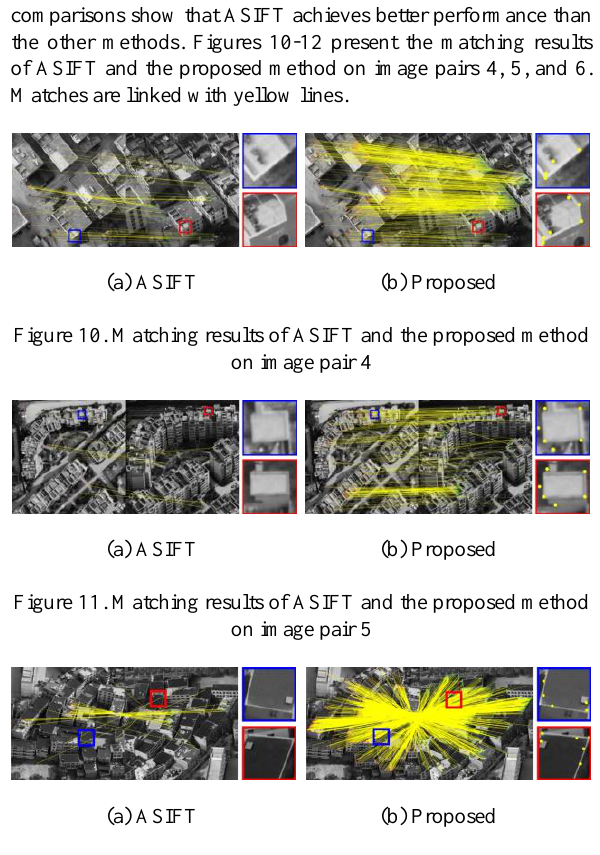
Figure 12. Matching results of ASIFT and the proposed method on image pair